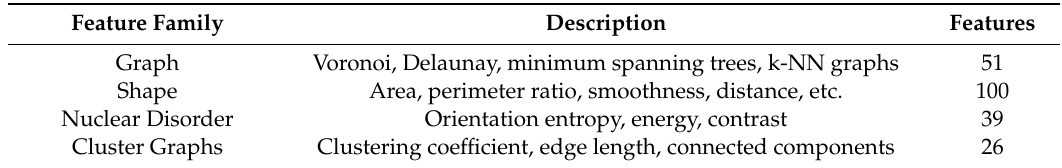
Figure 1. Feature maps of a patient that did not progresses (left) and one who progressed (right). Nuclear segmentation results representing the nuclear shape ( a , b ). Nuclear spatial arrangement represented through the Delaunay triangulation ( c , e ) Voronoi tessellation ( d , f ), and Minimum Spanning Trees ( g , i ). Disorder in localized nuclear orientation ( h , j ). Table 1. Summary of QH based features to describe tumor